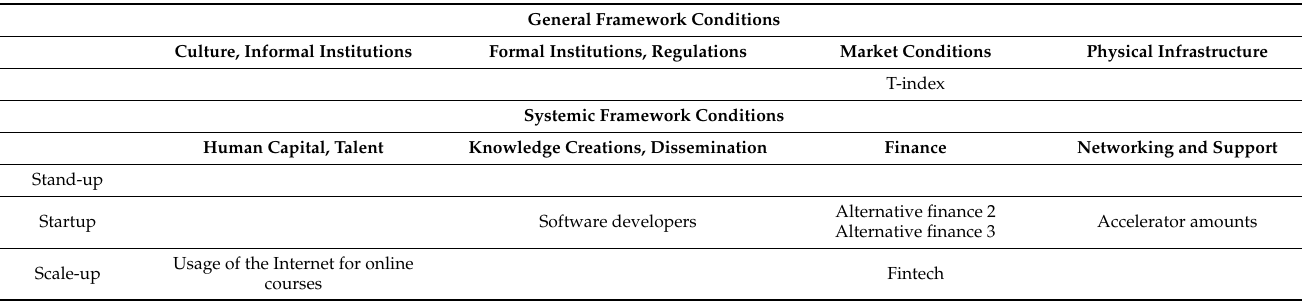
Table 10. The least developed indicators of the digital entrepreneurial system of the Republic of Serbia in the digital dimension. General Framework